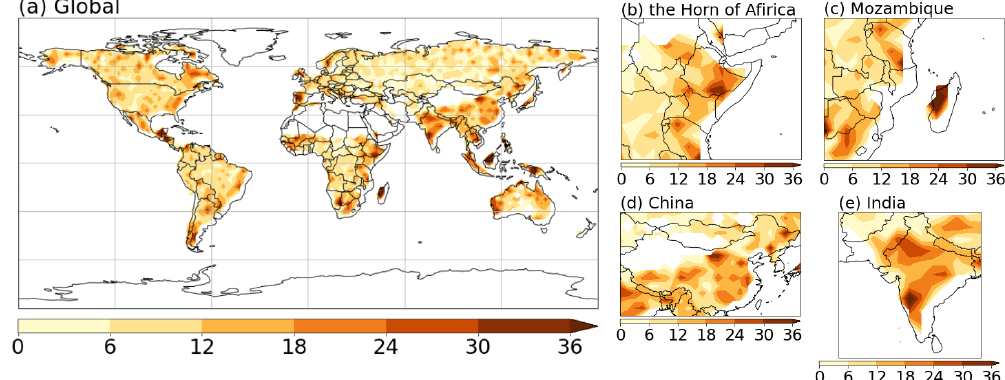
Figure 8. The number of drought cluster centroids based on ERA5-Land. (a) Global map, with a magnified view of (b) the Horn of Africa, (c) Mozambique, (d) China, and (e)